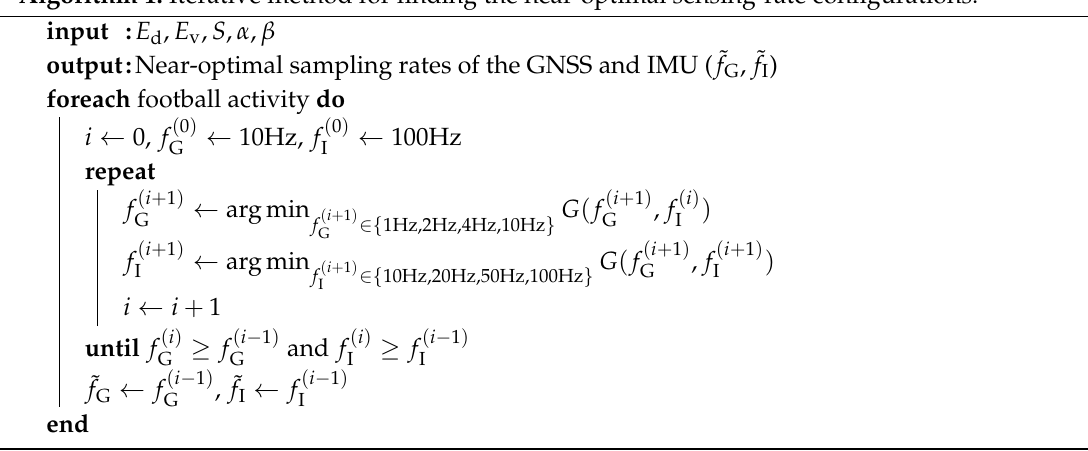
Algorithm 1: Iterative method for finding the near-optimal sensing-rate configurations.